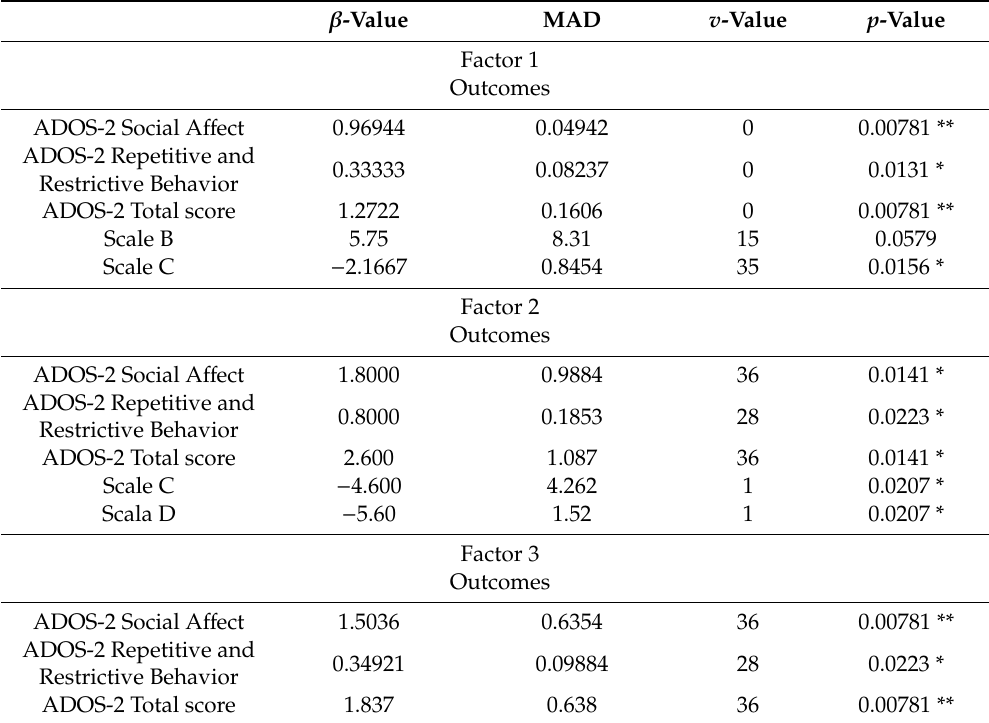
Table 9. Nonparametric regression between Q-CHAT and gold standard